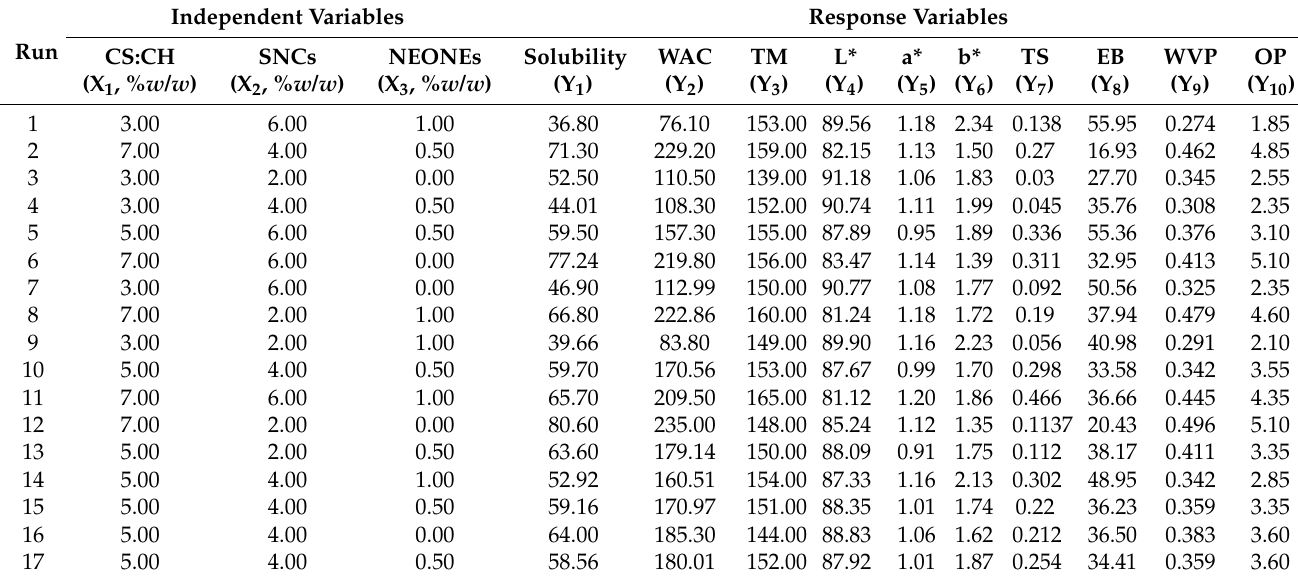
Table 1. Experimental design of chitosan–starch nanocomposite films and their corresponding physical and mechanical results. Independent Variables Response Variables Run